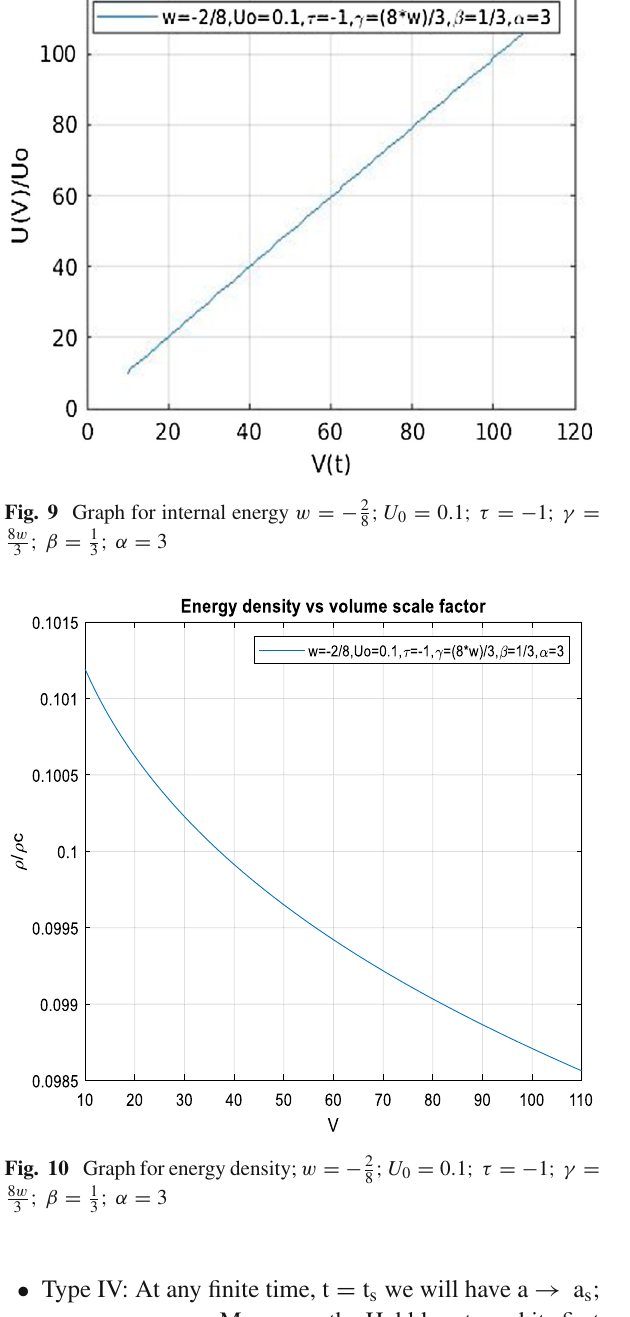
Fig. 12 Graph for EOS parameter; w = − 2 − 1 and − 0 . 01 e ; γ = 8 w